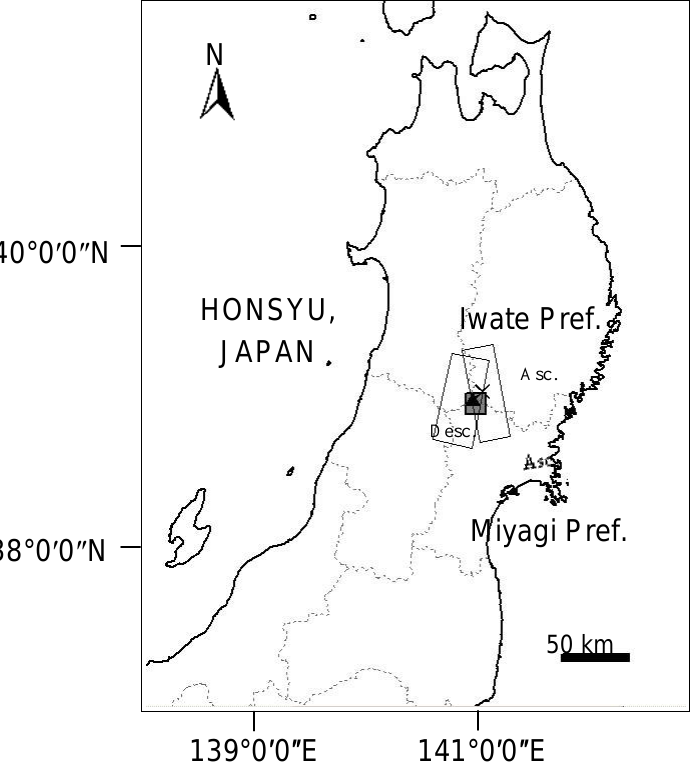
Figure 1. Northern part of Honshu Island, Japan, with earthquake epicenter of the Iwate-Miyagi Nairiku earthquake (cross) and Mt. Kurikoma (square). Blank squares show observation areas of ALOS (Advanced Land Observation Satellite) PALSAR (Phased Array type L-band Synthetic Aperture Radar) full polarimetric mode. “Asc.” orbit data was obtained on 4 June 2009. Observation dates of “Desc.” orbits were 19 May 2006, 24 August 2008, 9 October 2008, and 24 November 2008. Shaded square corresponds with the area shown in Figure